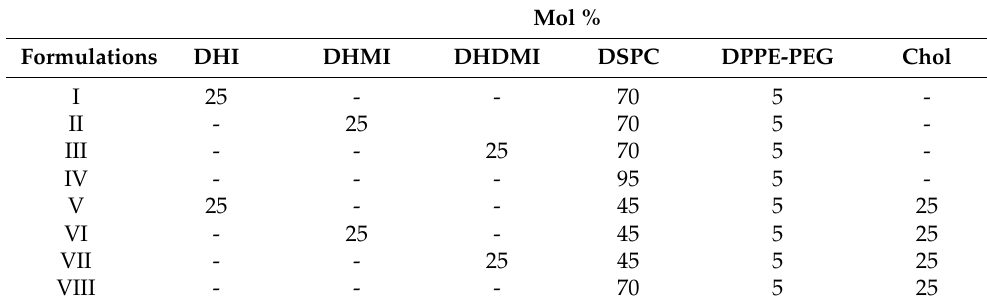
Table 3. Lipid composition of liposomes under